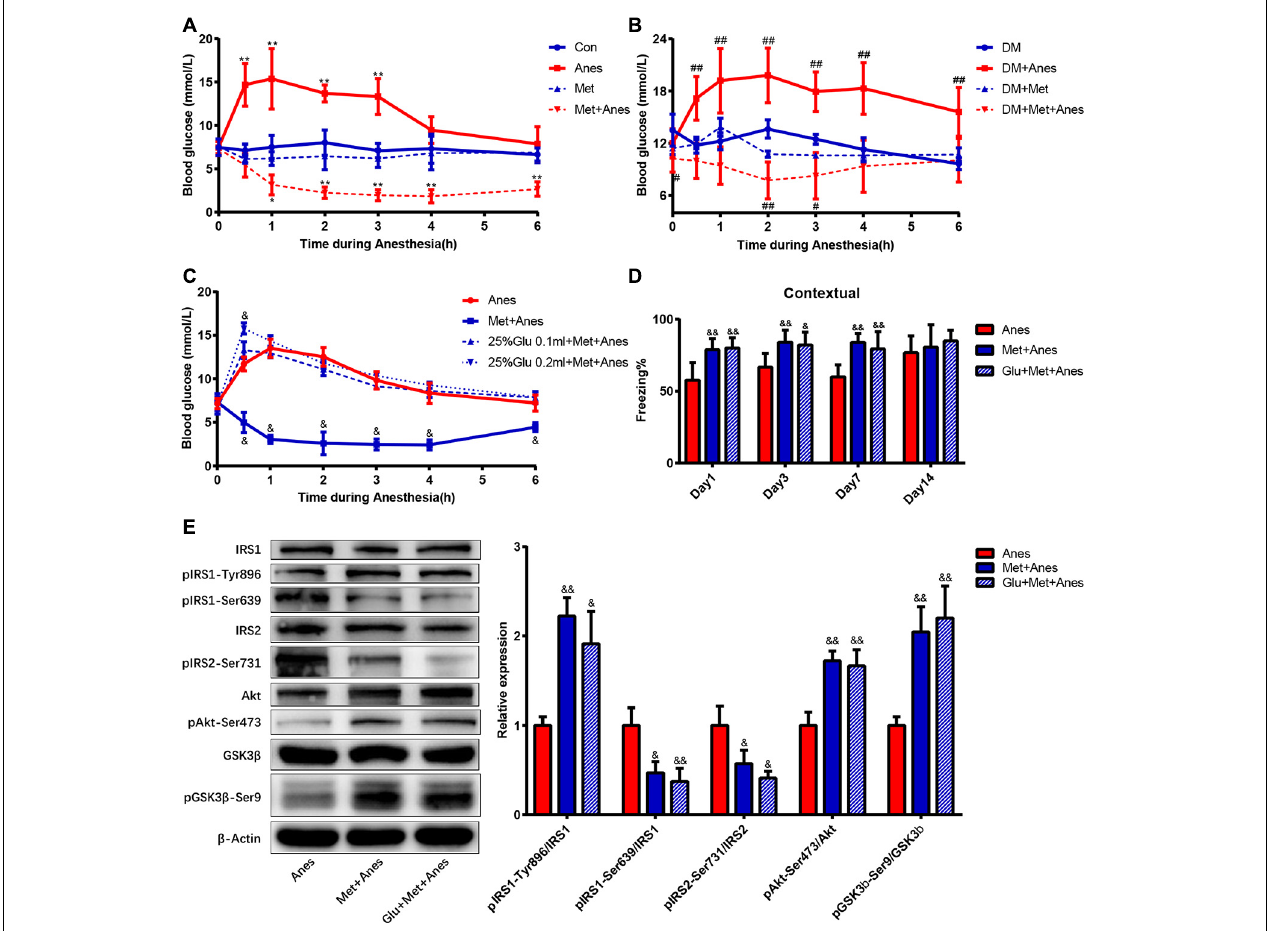
FIGURE 5 | Metformin improves hippocampal IR and contextual fear memory, independent of antiglycemic effects. (A,B) Changes in blood glucose levels during anesthesia among adult WT mice (A) and T2DM mice (B) with or without metformin pretreatment ( n = 4–6). (C) Changes in blood glucose levels during isoflurane anesthesia among WT mice receiving pretreatment with vehicle (Anes), metformin (Met + Anes), 25% glucose 0.1 ml plus metformin (25% Glu 0.1 ml + Met + Anes), or 25% glucose 0.2 ml plus metformin (25% Glu 0.2 ml + Met + Anes) ( n = 4 for each group). Blood glucose levels are expressed as mean ± SD and compared by repeated measures ANOVA followed by Bonferroni multiple comparisons tests. Repeated measures ANOVA revealed a significant effect of treatment in adult WT mice [ F ( 3 , 18 ) = 84.091, P < 0.001] and T2DM mice [ F ( 3 , 13 ) = 30.604, P < 0.001], as well as a treatment × time interaction [WT mice: F ( 18 , 45 ) = 3.281, P = 0.001; T2DM mice: F ( 18 , 30 ) = 2.149, P < 0.001]. There was also a marked effect of time in WT mice [ F ( 6 , 13 ) = 8.552, P = 0.001], but not T2DM mice [ F ( 6